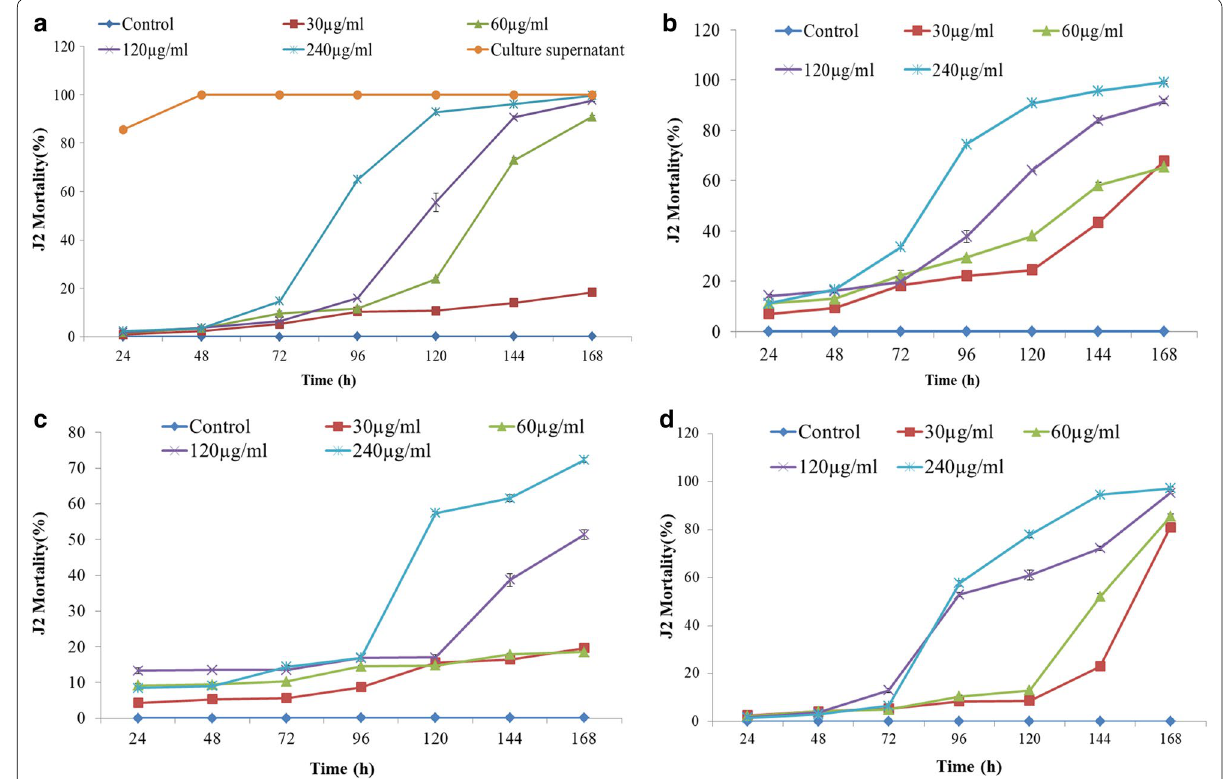
Fig. 1 Juvenile mortality in M. incognita treated with S. antibioticus strain M7 metabolites: a EtOAc extract and culture supernatant, b actinomycin V, c actinomycin